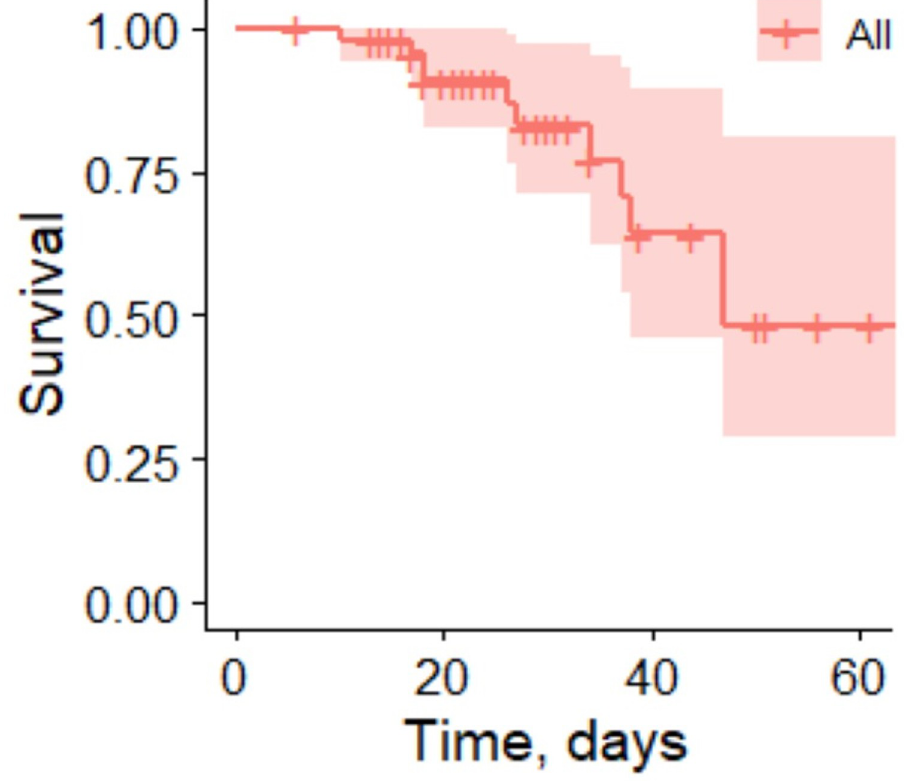
Fig 1. Kaplan-Meier survival curve with associated 95% confidence intervals (shaded area) for patients admitted with COVID-19 infection to ICU of N.V. Sklifosovsky Research Institute for Emergency Medicine, Moscow from April to July 2020. The fraction of survival is expressed on the y-axis, while time (days) of the observation period is expressed on the x-axis. Vertical traits indicate censored data (hospital discharge).